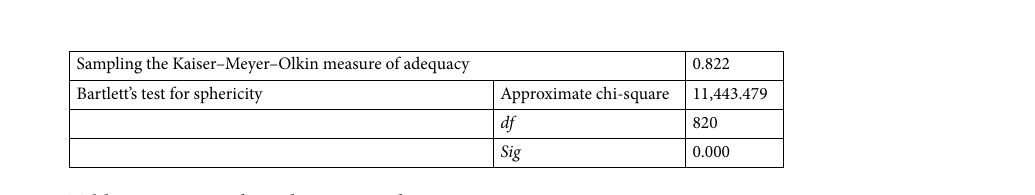
Table 1. KMO and Bartlett test results.